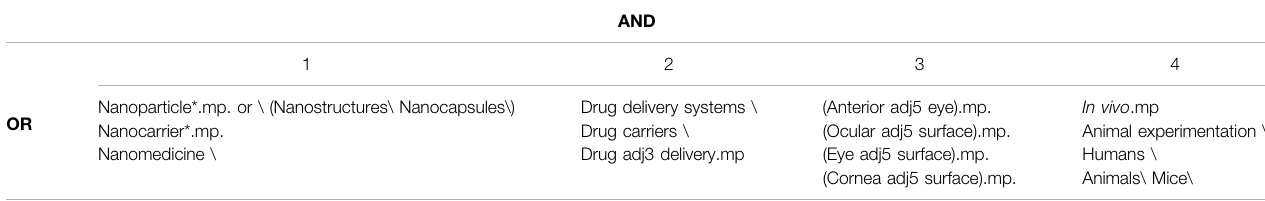
TABLE1| Systematicsearchthematicallystructuredintofourcategoriesof “ MeSHterms ” and “ freetextwords ” usedforliteraturesearchinMedlineandEmbasedatabases using the Ovid interface. The “ MeSH terms ” and “ free text words ” in each category were combined with “ OR ” to broaden the search within the category. The search results from all four categories were then combined with “ AND ” to narrow the search.